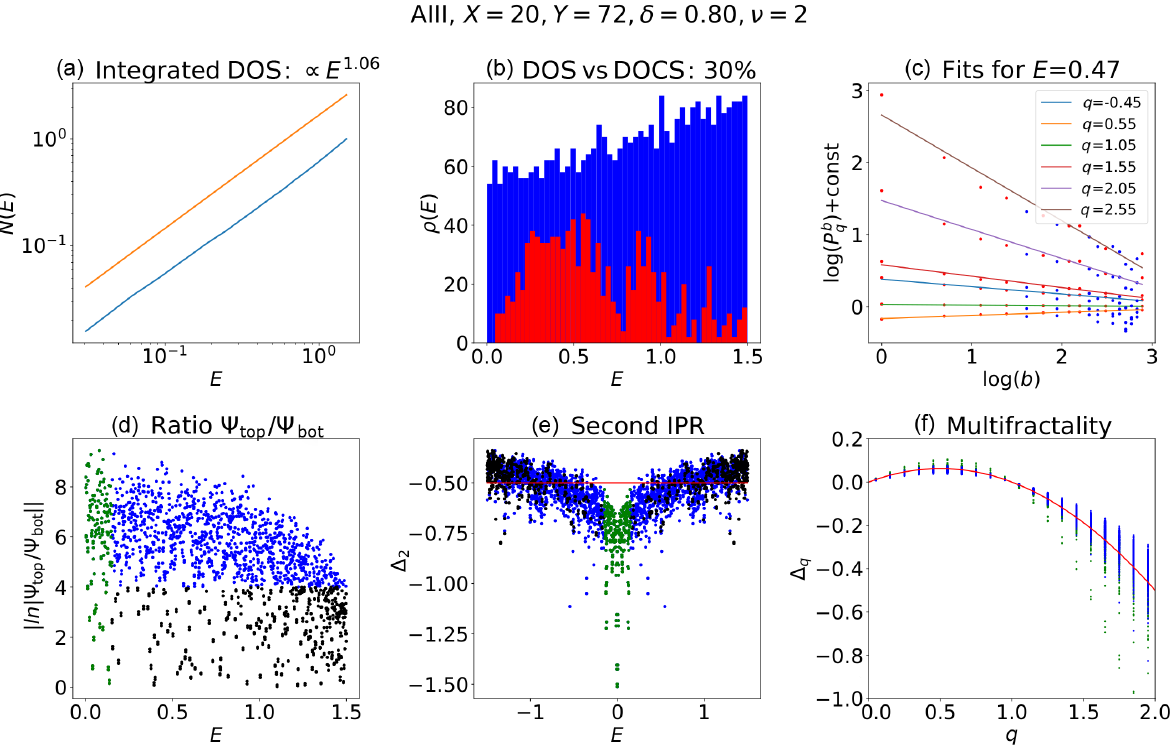
FIG. 10. Numerical exact diagonalization results for the disordered surface states of the 3D class AIII topological superconductor lattice model defined by Eqs. (21) – (26). The bulk is tuned to the ν ¼ 2 phase as indicated by the blue dot in Fig. 9. Shown are results for ; t; Δ g only near the top and bottom slab surfaces. For each a system of surface size L ¼ 72 with box disorder on all couplings λ ∈ f t 0 ; μ s ¯ ¯ λ − δ ¯ λ ¯ λ ¯ λ 0 , ¯ t ¼ 2 , and ; t 0 ¼ 4 , ¯ μ parameter the disorder spans λ ∈ ½ þ δ (cid:3) , where δ ¼ 0 . 8 and the average coupling strengths are s ¼ ¯ Δ ¼ 1 . Results here characterize eigenstates across the energy ( E ) spectrum for a single, typical realization of the disorder. The energy E is measured in units of t 0 , and the bulk gap is E ¼ 1 . 5 . (a) The integrated density of states N ð E Þ is shown. Throughout the gap, a power law N ð E Þ ∝ E α with α ¼ 1 . 06 is obeyed. The perfect power law is shown slightly shifted in orange. (b) Histogram of the density of critical states (DOCS) versus the overall density of states (DOS). A state is critical, once its anomalous multifractal exponents Δ match q 2 . 83 [20,21]. the class A QHPT prediction Δ ð QHPT Þ q ≃ ð 0 . 25 Þ q ð 1 − q Þ [7,35] within 4% for 75% of the q ∈ ½ 0 ; q below freezing, q c (cid:3) c ¼ The total DOS is shown in blue, the critical fraction is colored red. (c) Fits for extracting the multifractal exponents are shown for an exemplary state at E ¼ 0 . 47 . Commensurate box sizes are shown as red dots, incommensurate ones (padded with zeros) are blue. When fitting, only commensurate boxings are taken into account, and these satisfy the expected linear relation very well even for large q . One can observe that log P b depends linearly on log b for a single state. (d) Vertical depth profile for the surface states. The ratio of the top q and bottom surface probabilities [Eq. (31)] is plotted versus energy. The vast majority are localized on either one of the two faces with open boundary conditions; hence, the width of the sample is sufficient to study surface properties. States that extend into the bulk are colored black, high-energy surface states are blue, and low-energy surface states are green. This color code is also used in (e) and (f). At E ¼ 1 . 5 , where the gap closes, almost all states extend into the bulk. (e) Second anomalous dimension Δ 2 as a function of energy. For the high-energy surface states ( E > 0 . 3 , blue) there is reasonable agreement with Δ ð QHPT Þ 2 ¼ − 0 . 5 . (f) Multifractal spectra for all surface states. There is good agreement of the high-energy states (blue dots) with the expected QHPT parabola [7,35] (red line). The low-energy states are strongly multifractal